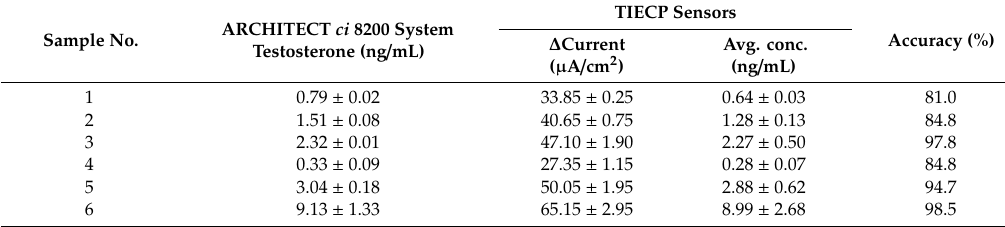
Table 1. Comparison of real sample measurement by ARCHITECT ci 8200 system and the TIECP sensors. Sample